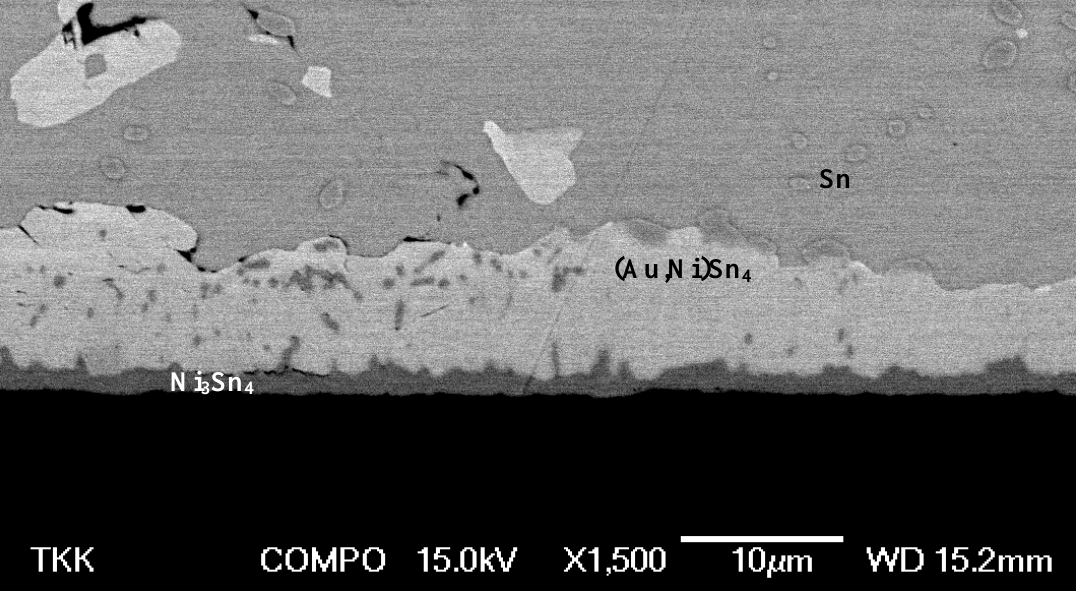
Figure 18. Plot of the IMC-thickness versus time in the (SnAg)/Ni/Au